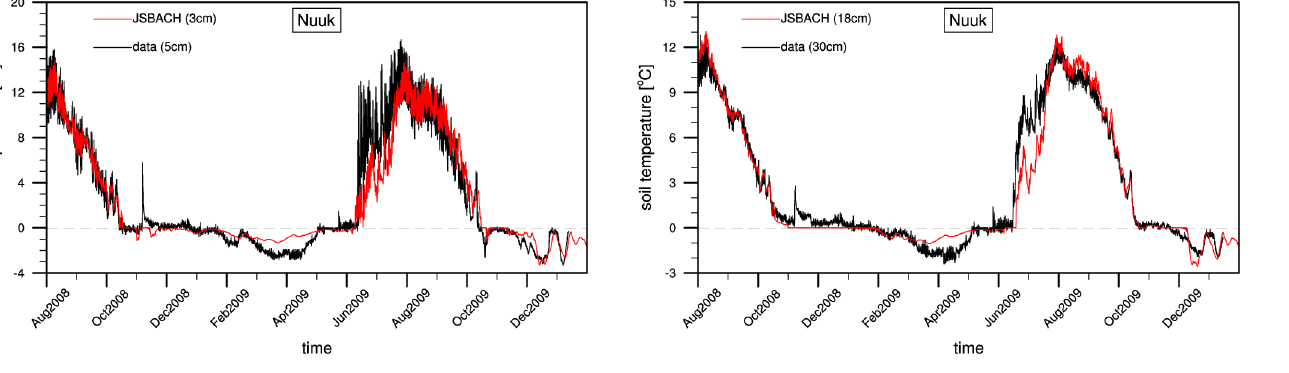
Fig. 3. Observed and simulated soil temperature at the Nuuk site. Observed soil temperature at 30cm is plotted with the black line and the red line shows the JSBACH-simulated soil temperature in the second layer (ca.